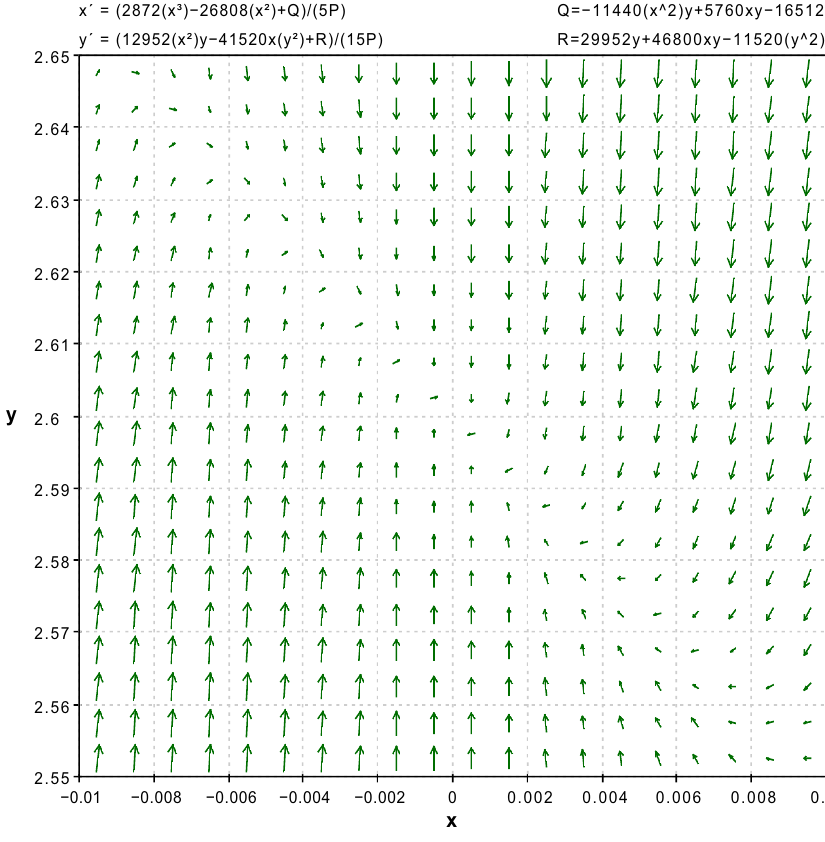
Fig. 1 Phase portrait in the x – y plane for b =